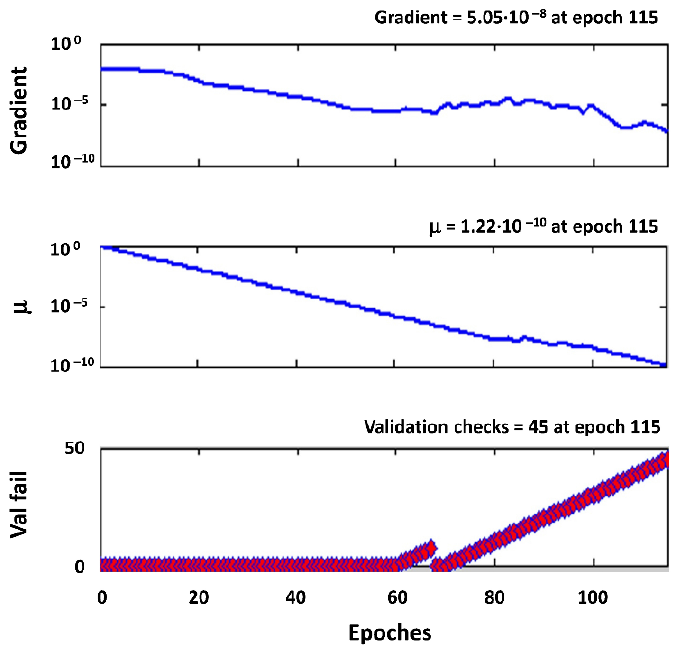
Figure 4. ANN training state.